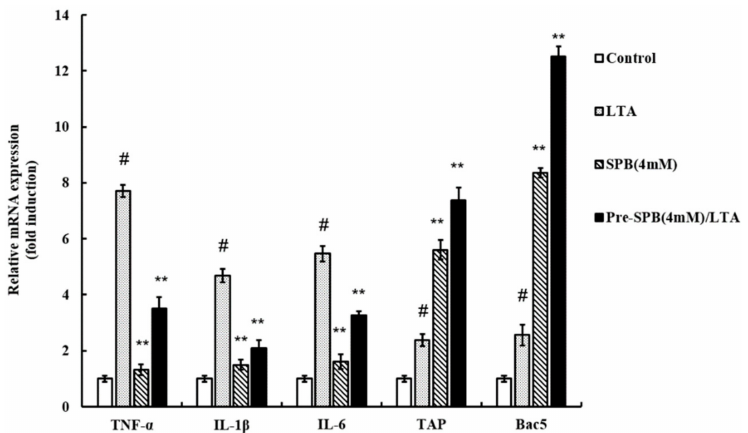
Figure 2. The effect of SPB on LTA-induced TNF- α , IL-1 β , IL-6, TAP, and Bac5 production. Gene expression was normalized to the expression of the reference gene 18S rRNA. Each column shows the means ± SE of triplicates of three independent experiments. # p < 0.05 vs. control group; ** p < 0.01 vs. LTA group.